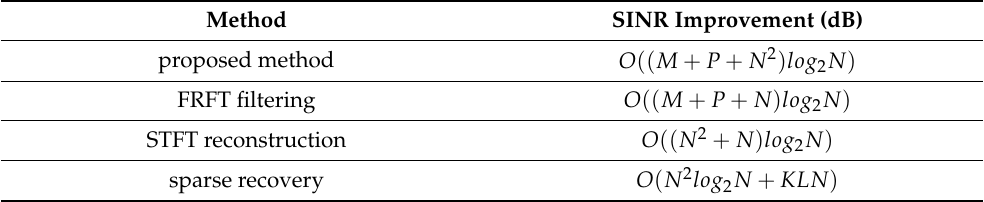
Table 2. Computational complexity comparison of various methods.